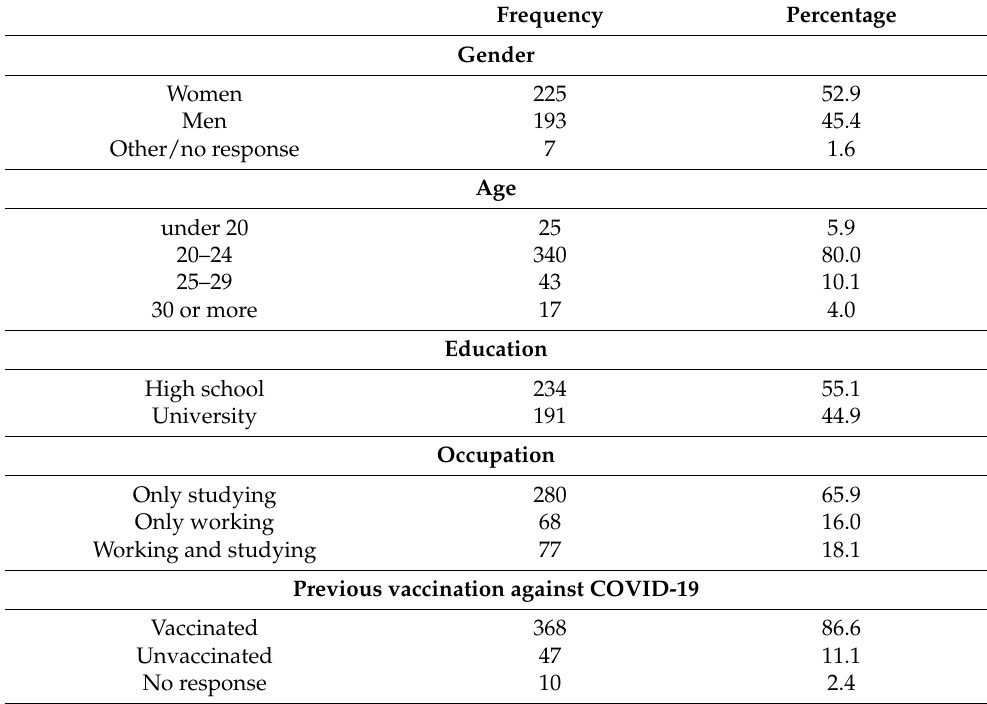
Table A1. The Sample